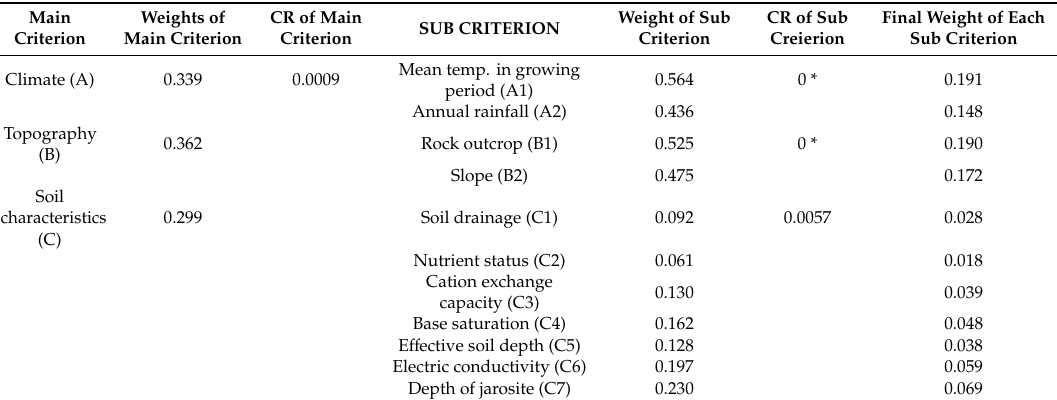
Table 7. Weights of all criteria using analytical hierarchy process (AHP).